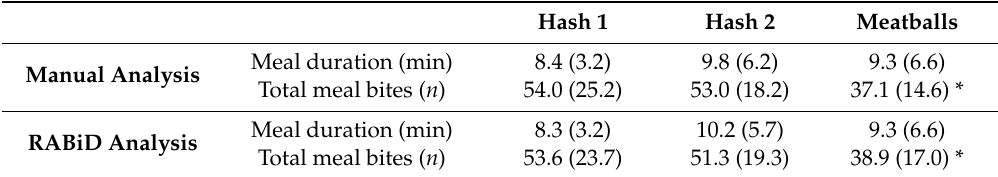
Table 4. Meal duration and total number of bites for three repeated meals from the same individuals; * p -value < 0.05 from linear mixed model comparing hash 1 vs. meatball